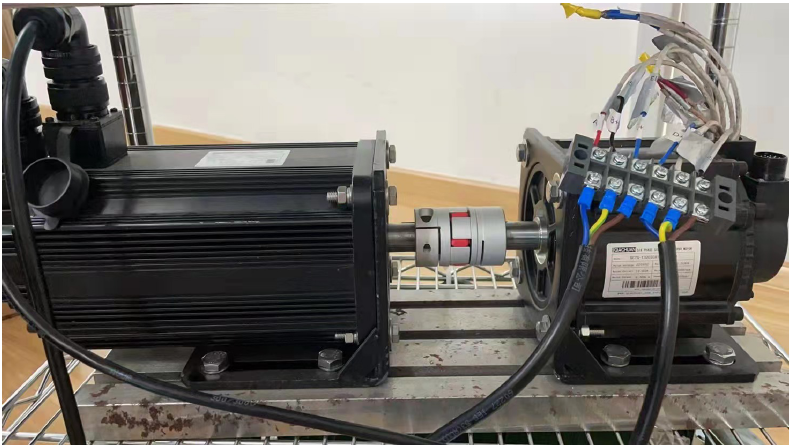
Figure 19. The experiment